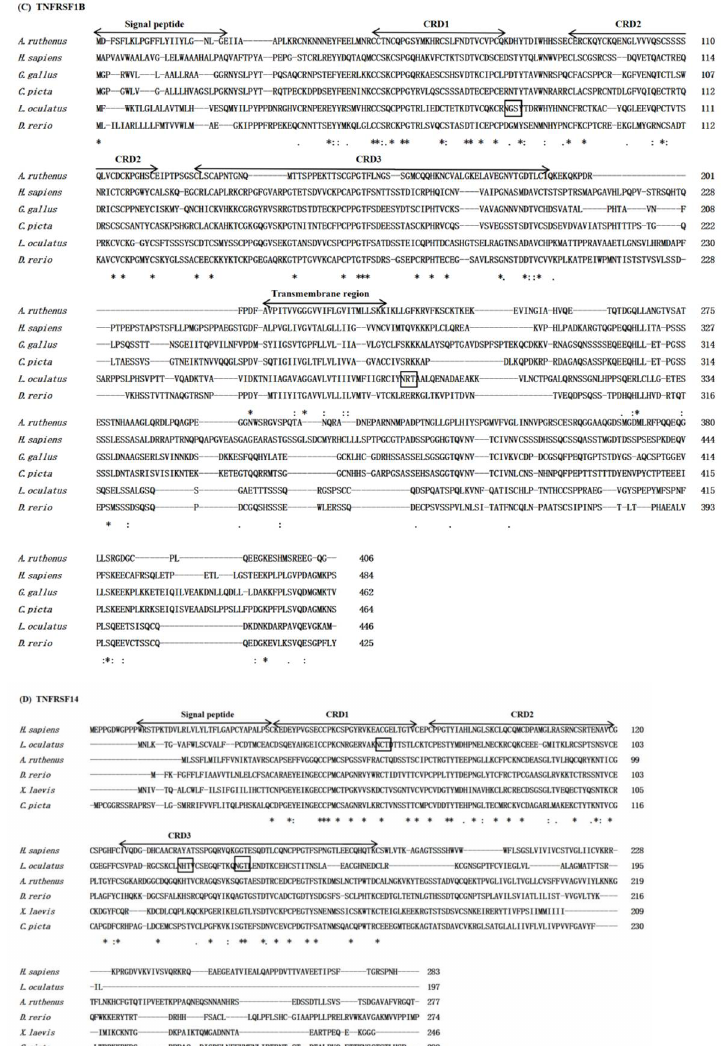
Figure 1. Multiple sequence alignment of TNFSF14 ( A ) and TNFRSF1A ( B ), TNFRSF1A ( C ), TN- FRSF14 ( D ) with selected homologs. Putative signal peptide, cysteine-rich domain (CRD), death domain (DD) and TNF homology domain (THD) in the spotted gar proteins are indicated by double arrows. The predicted N-glycosylated sites are boxed. Identical (*), most similar (:) and similar residues are indicated below the